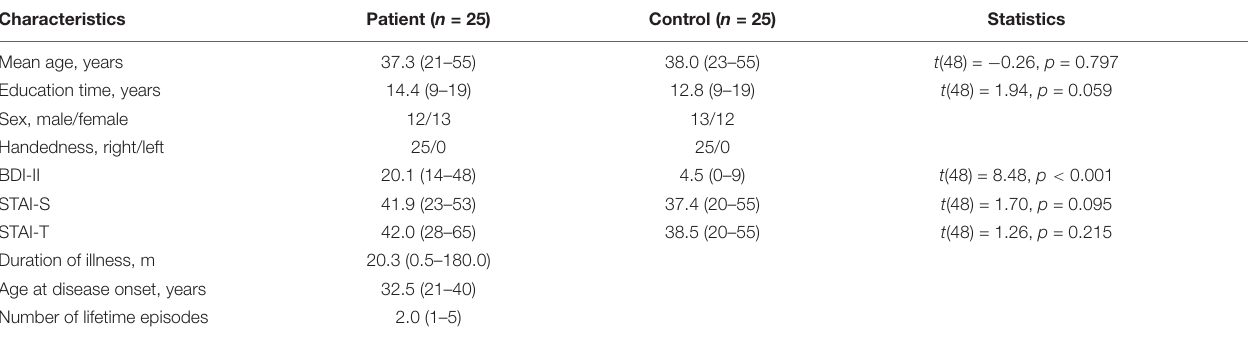
TABLE 1 | Demographic and clinical data of patient and control